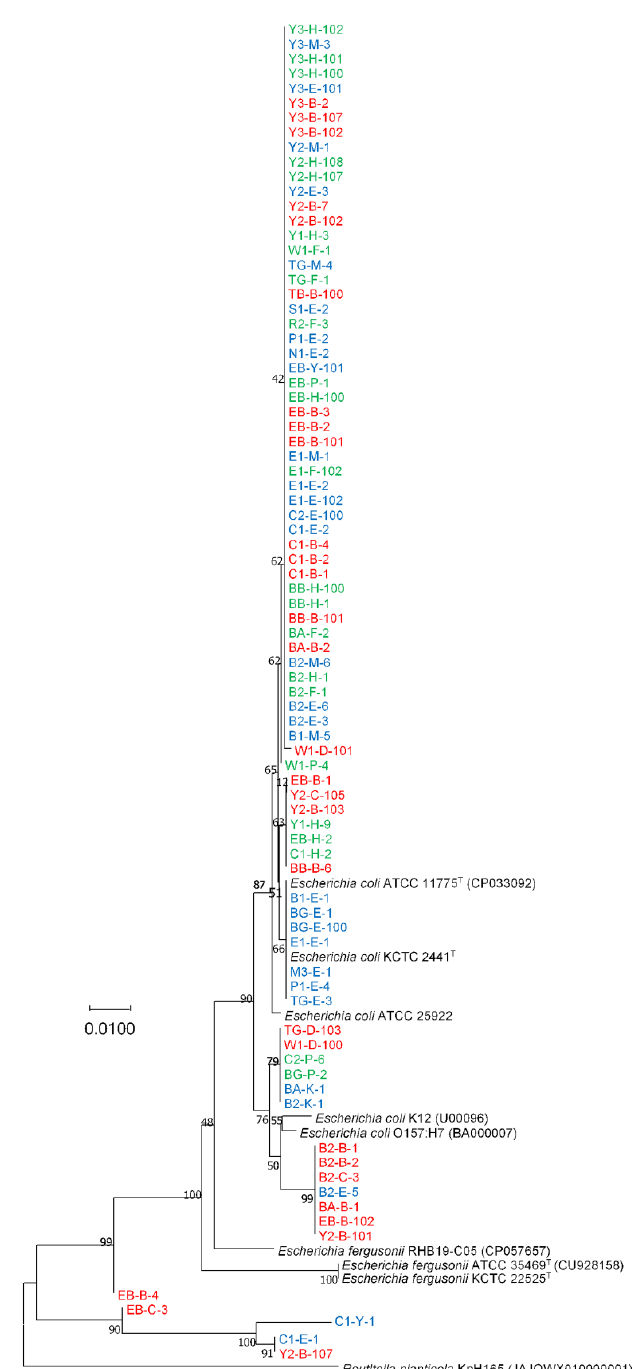
Figure 3. The neighbour-joining phylogenetic tree based on 583-bp adk gene sequences of isolated E. coli strains from patients with IBD or IC. The numbers at the nodes indicate the percentage of 400 bootstrap replicates. Routltella planticola KpH165 was used an outgroup. Strain names in red and blue represent IBD (red = CD; and blue = UC), and green represents IC. The accession numbers are provided in parentheses whose adk gene sequences were retrieved from whole genome